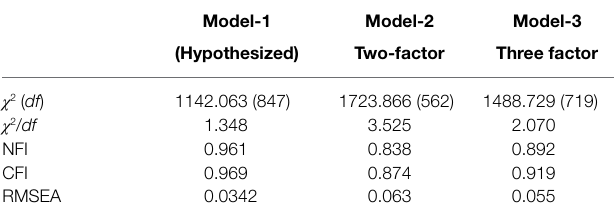
TABLE 6 | Model fit comparison hypothesized vs. alternate